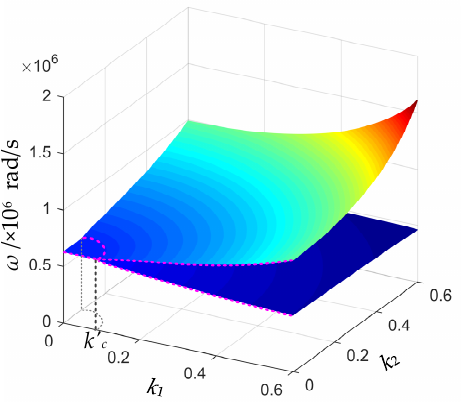
Figure 5. Theoretical values of the operating angular frequency ω.